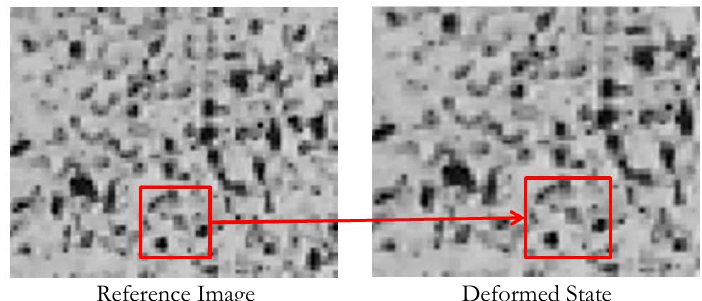
Figure 1: Changes in a spot pattern upon application of a specific strain.